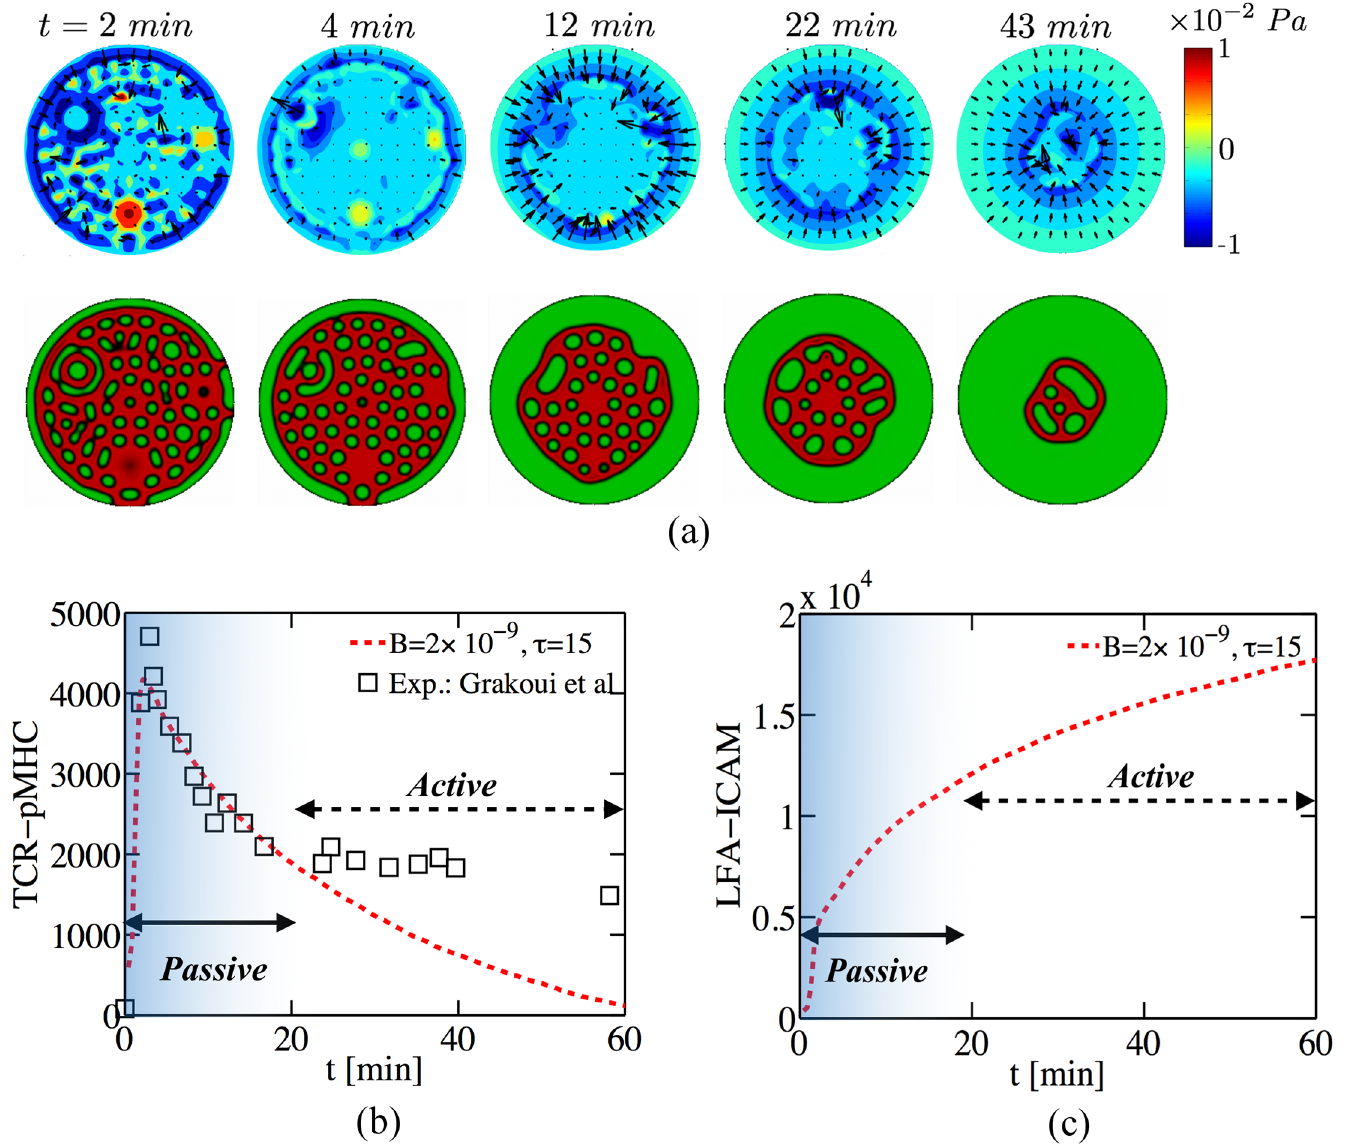
Fig 3. (a)-(c) Simulation of Eqs 1 – 4 with B = 2 × 10 − 9 and τ = 15 and the other dimensionless numbers are reported in Table 2. (a) Contour plots of the time history of the pressure ( p ), along with the velocity ( − h 2 r p ). The second row shows the corresponding protein pattern of TCR-pMHC and LFA-ICAM, see Fig 3 for color scale. At short times ( t < 4 min ) the nucleation and coalescence of protein domains generates a local flow field. At late times ( t (cid:12) 12 min ) a global centripetal flow is generated that “ compress ” the TCR cluster radially generating a “ bulls-eye ” -like protein pattern, which becomes unstable at t (cid:3) 60 min . (b-c)The total number of attached receptors of (b) TCR-pMHC and (c) LFA-ICAM. (b-c) Direct comparison between the total number of attached TCR in the IS in simulation and in experiment [3] shows that the results are in good agreement for t < 20 min . This suggests that passive dynamics suffices to describe the short-time formation and organization of protein domains while the long-time IS dynamics and its stability is likely controlled by active